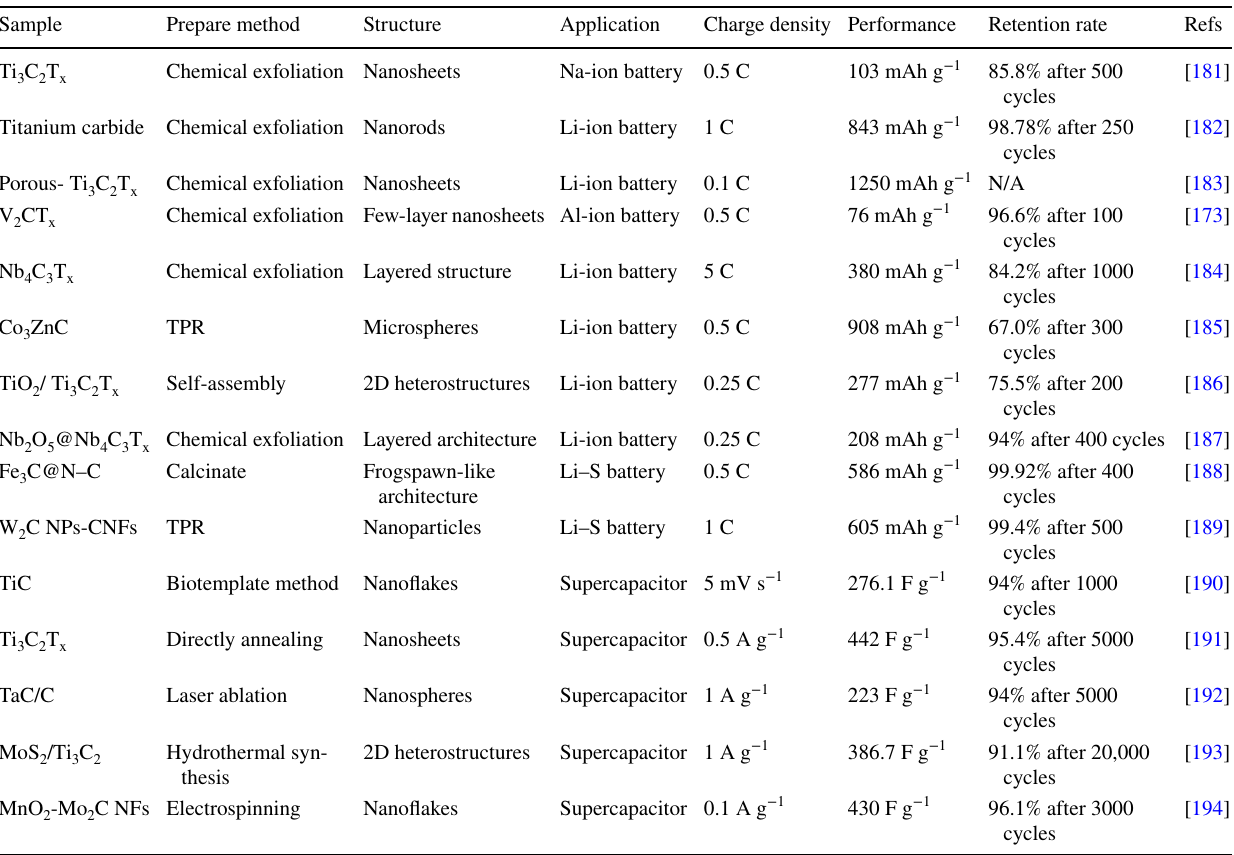
Table 4 Energy storage performance of transition metal carbides Sample Prepare